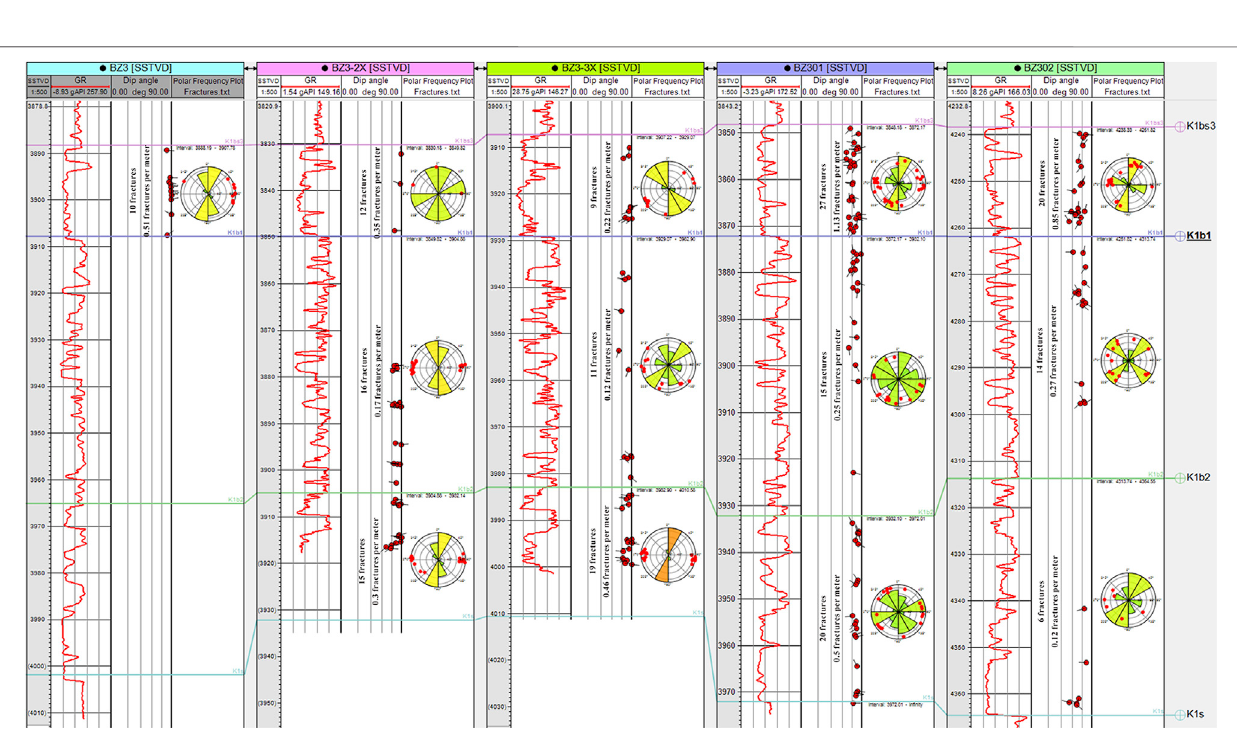
FIGURE 4 | Fracture development of Bozi 3 gas